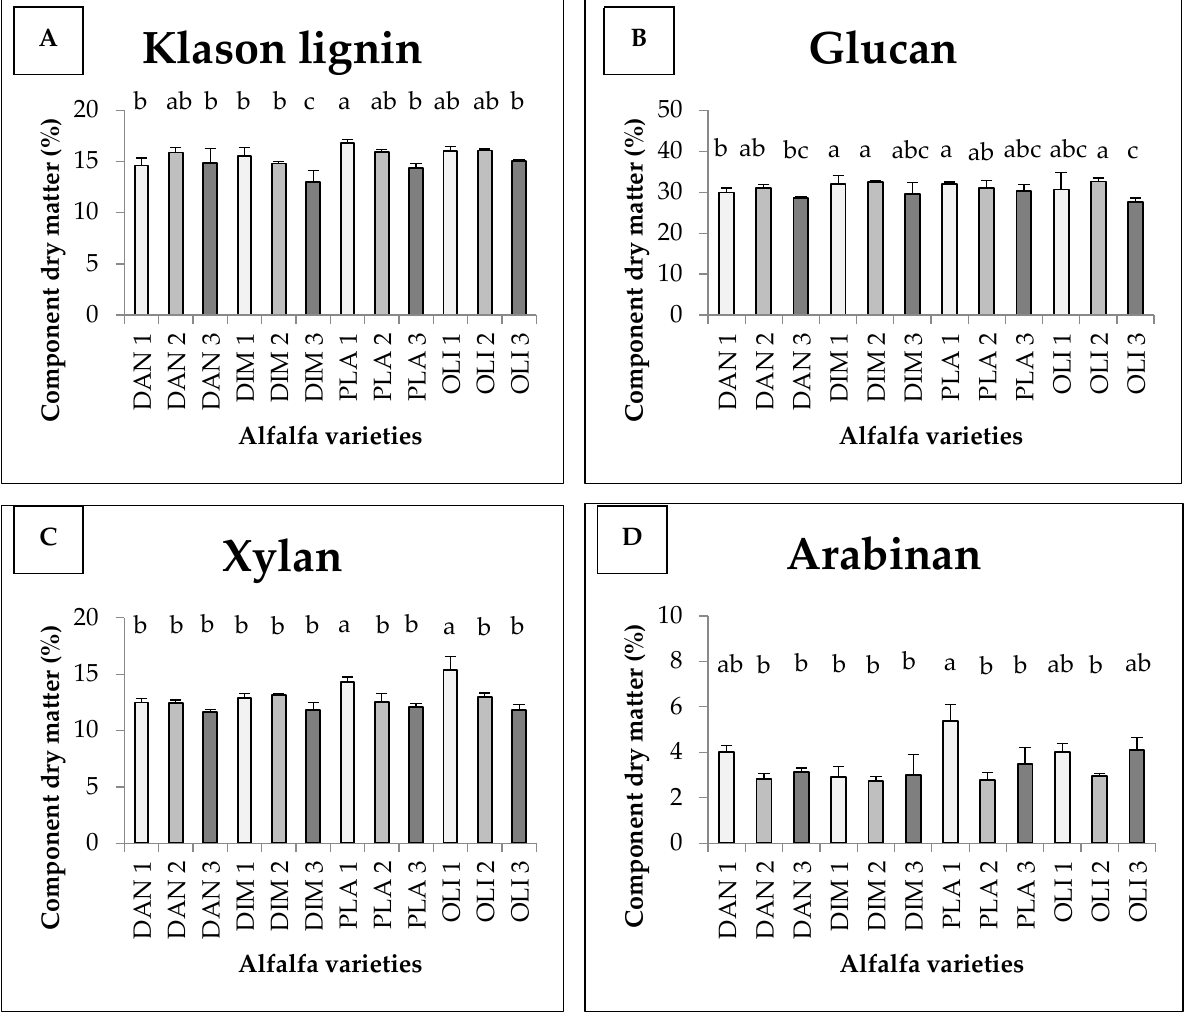
Figure 2. Average Klason lignin ( A ) contents and glucan ( B ), xylan ( C ) and arabinan ( D ) components of different alfalfa varieties as a function of harvest time (+SD). Different letters above the columns refer to significant differences ( p ≤ 0.05).